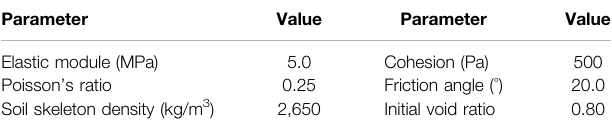
Table 1 . On the workstation equipped with a dual Intel Xeon E5